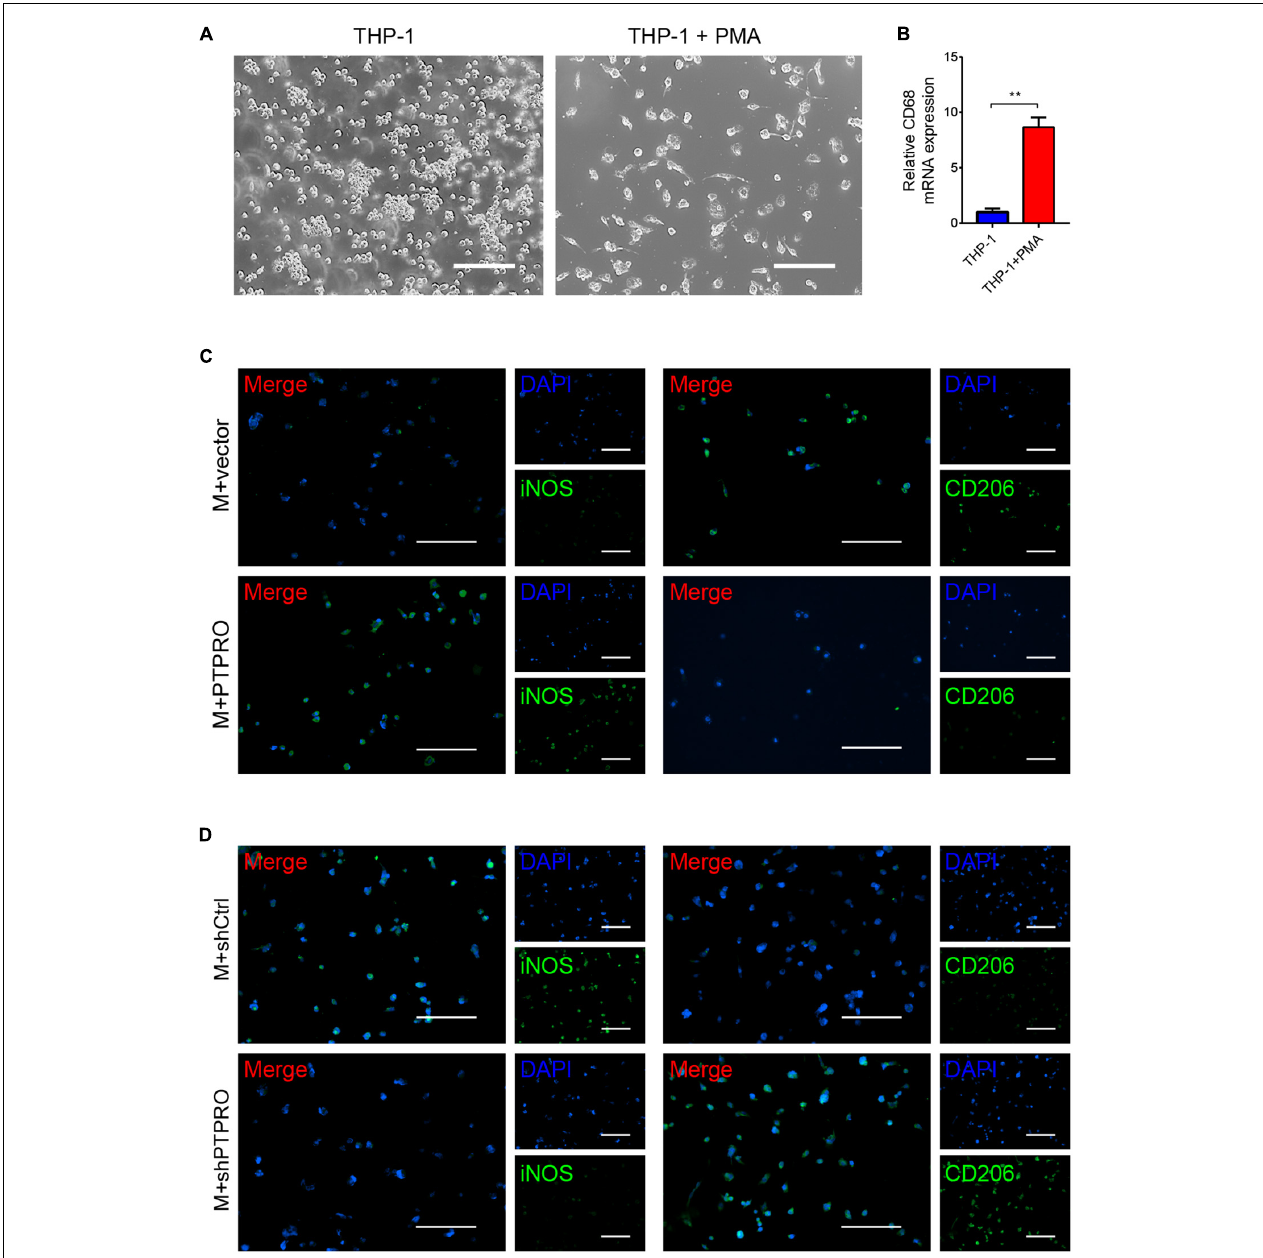
FIGURE 2 | Tumor-derived PTPRO reeducated macrophages toward a M1-like phenotype. (A) THP-1 cells were treated with PMA for 24 h. Representative images of THP-1 derived macrophages were shown. Scale bars = 50 µ m. (B) qRT-PCR was used to detect the expression of CD68 (macrophage marker) in THP-1 cells. (C) Representative images of immunofluorescence staining of iNOS and CD206 in THP-1 derived macrophages after incubating with ZR-75-1-vector or ZR-75-1-PTPRO cells for 48 h. Scale bars = 50 µ m. (D) Representative images of immunofluorescence staining of iNOS and CD206 in THP-1 derived macrophages after incubating with ZR-75-1-shCtrl or ZR-75-1-shPTPRO cells for 48 h. Scale bars = 50 µ m. Error bars, SEM. ** P < 0.001 by Student’s t -test.